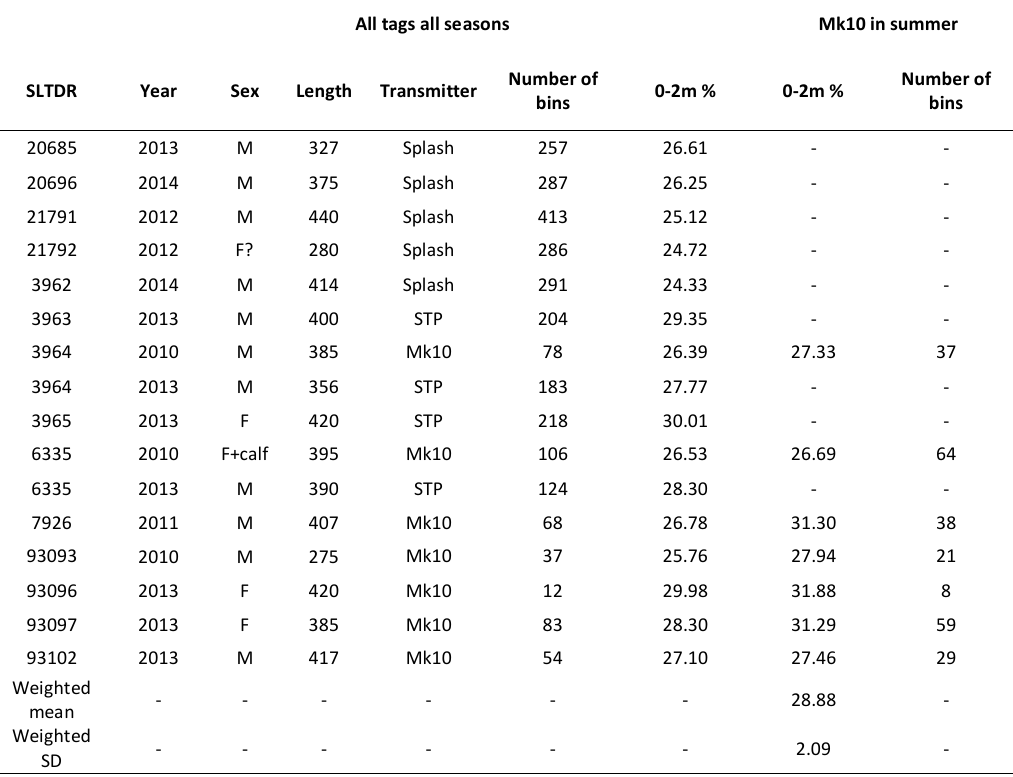
Table 1: List of 16 SLTDRs that provided data on surfacing time (0-2m) from narwhals in East Greenland. The SPLASH and STP tags were filtered to include data where the sum of all bins was larger than 98 and the surfacing time was within 20 to 35%. For Mk10 tags the filtering includes data